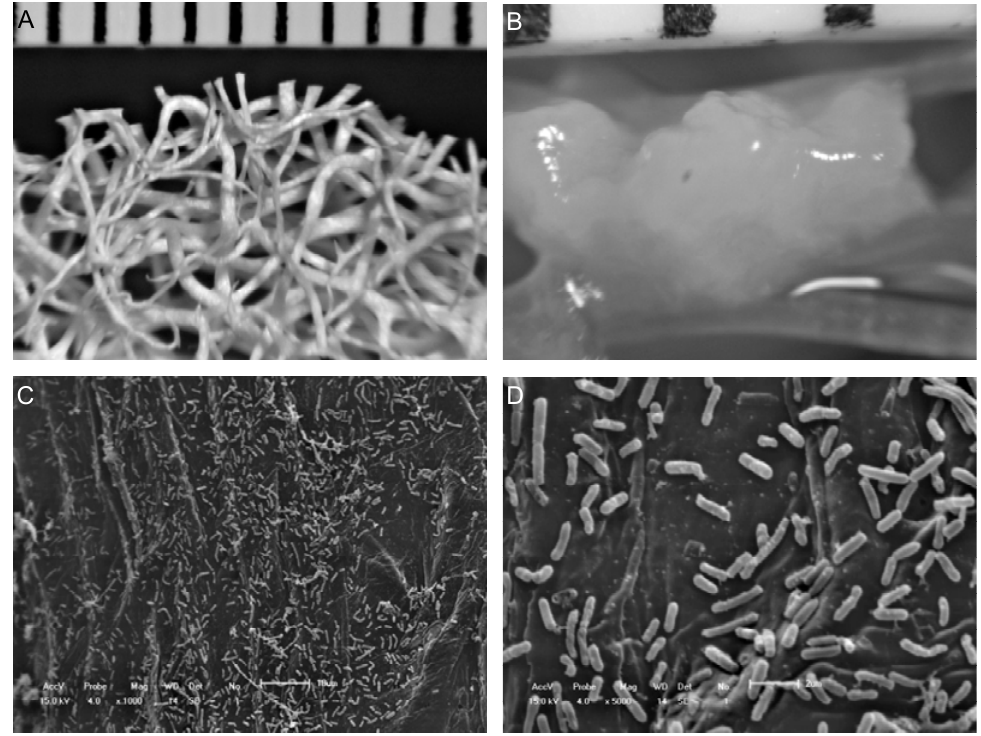
Figure 1. Photographs showing ( A ) uninoculated fibrous network of loofa sponge; ( B ) colony of B. firmus strain 37 grown on loofa sponge fibers; and ( C , D ) scanning electron micrograph of B. firmus strain 37 immobilized on surface of a single loofa sponge fiber. The detail in the superior position of the pictures A and B is a graduated scale in millimeters.